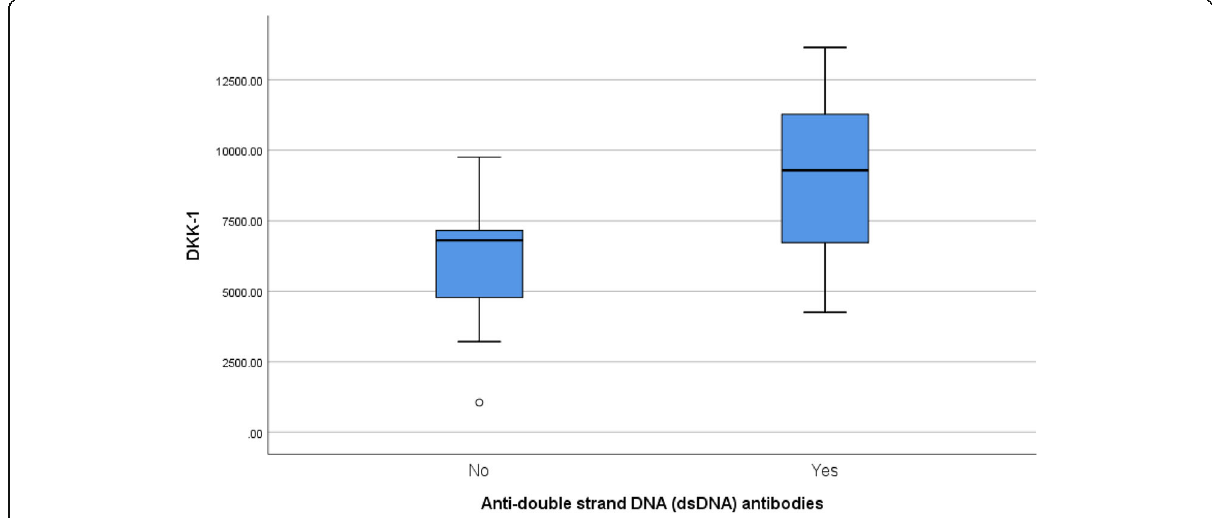
Fig. 2 Relation of anti-double-stranded DNA (dsDNA) and DKK-1 concentration among SLE patients